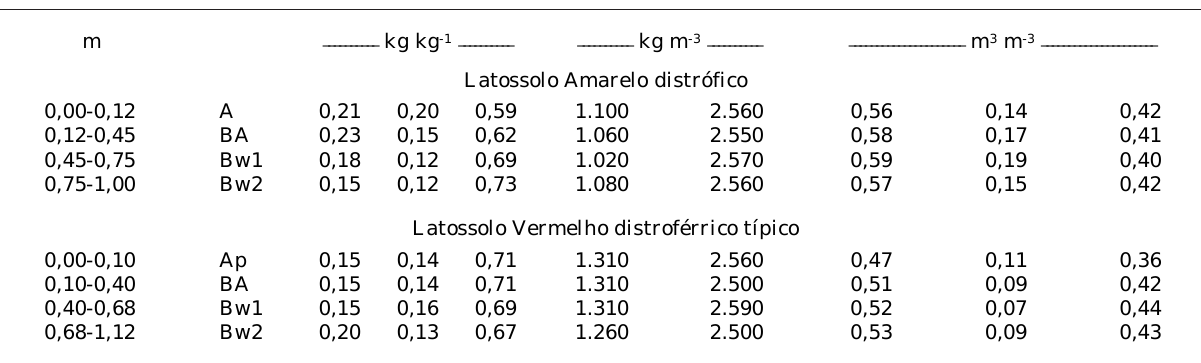
Quadro 1. Características físicas dos horizontes pedológicos dos solos estudados Profundidade Horizonte Areia Silte Argila